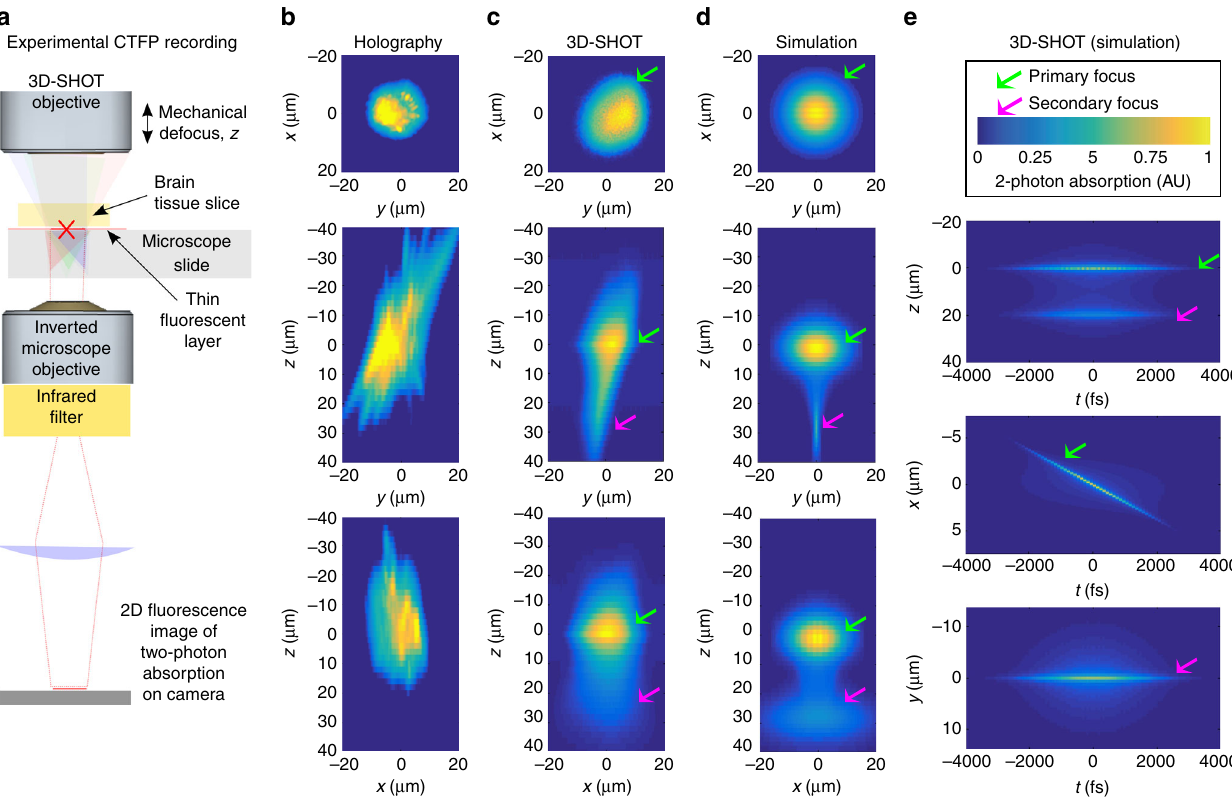
Fig. 2 Optical characterization of the spatial resolution of CGH vs. 3D-SHOT. a We used a fl uorescent calibration slide and an inverted microscope to compare two-photon absorption patterns in 3D. b For conventional holography, we consider a 10 µ m diameter disk target, and show (from top to